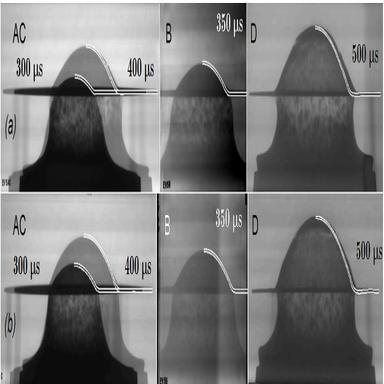
Experimental flash X-ray results and comparison with the calculations (shown as half plate white contours) for the solid glass microspheres loaded by the configuration U charge, ρ0 = 1.54 g/cm3 (a) and configuration V charge, ρ0 = 1.48 g/cm3 (b).